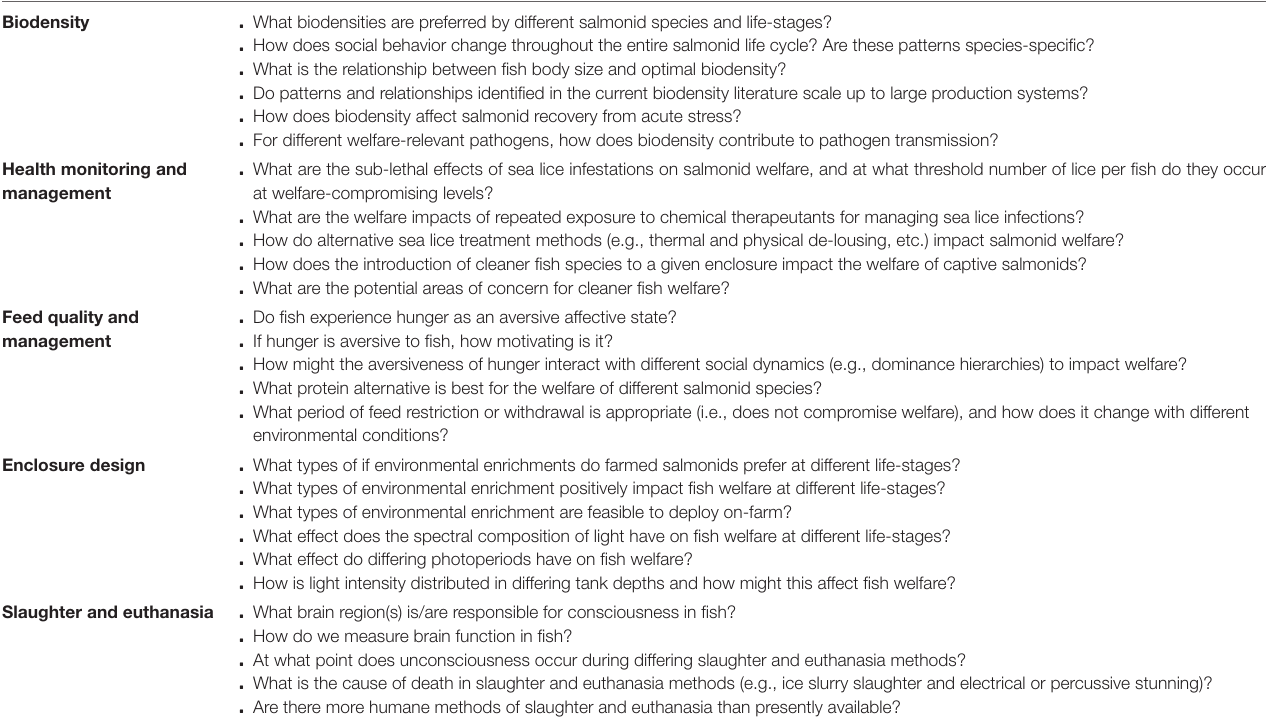
TABLE 2 | Examples of outstanding research questions that exist in each Research Gap identified herein, as informed by the Scientific Committee, Code Development Committee, and the authors’ perspective as fish welfare researchers.